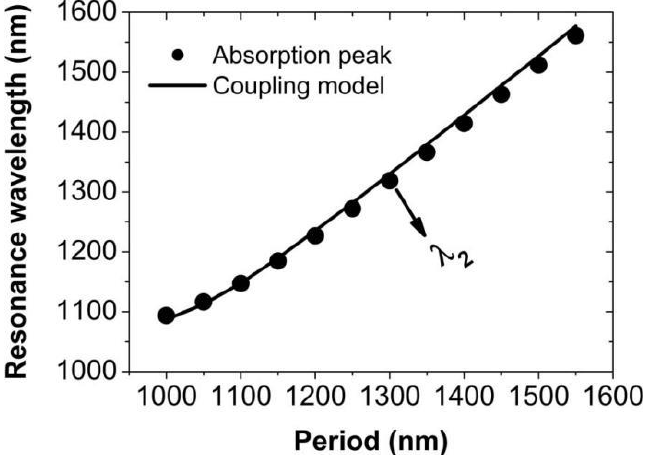
Figure 5. Comparison of the positions of absorption peaks with those predicted by the coupling model of two oscillators.